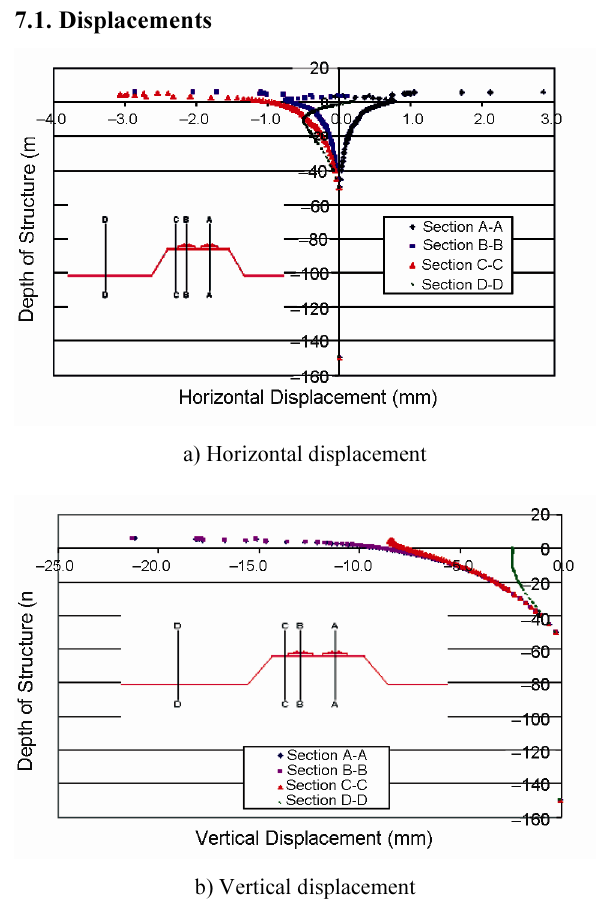
Fig. 6. Variation of displacements